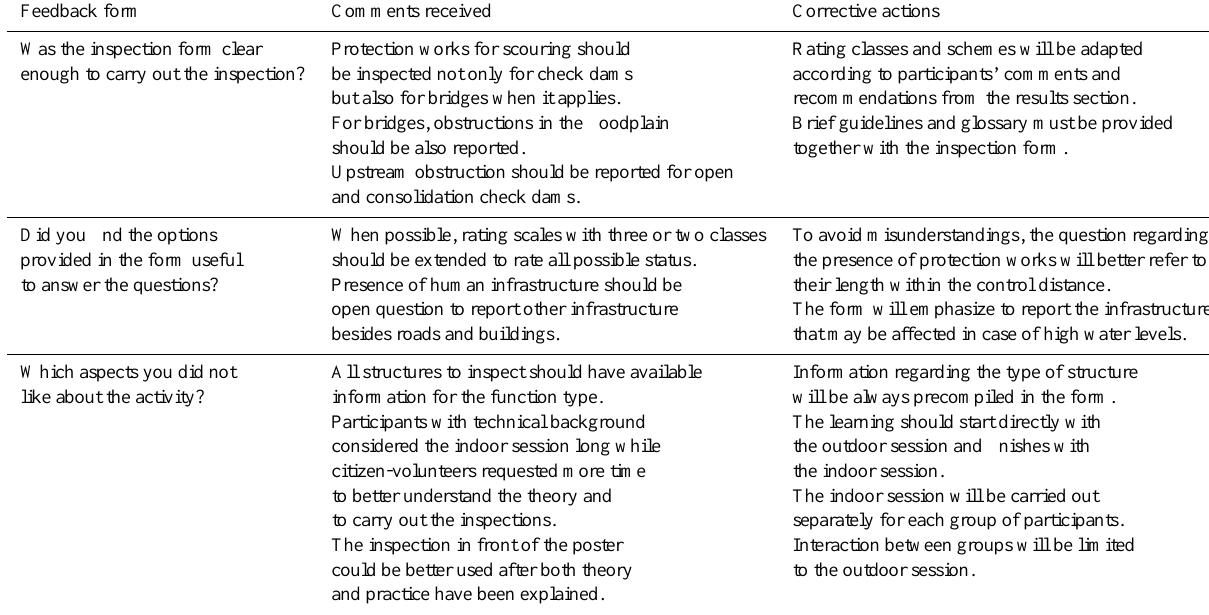
Table 7. Feedback of participants to initiate corrective actions in survey